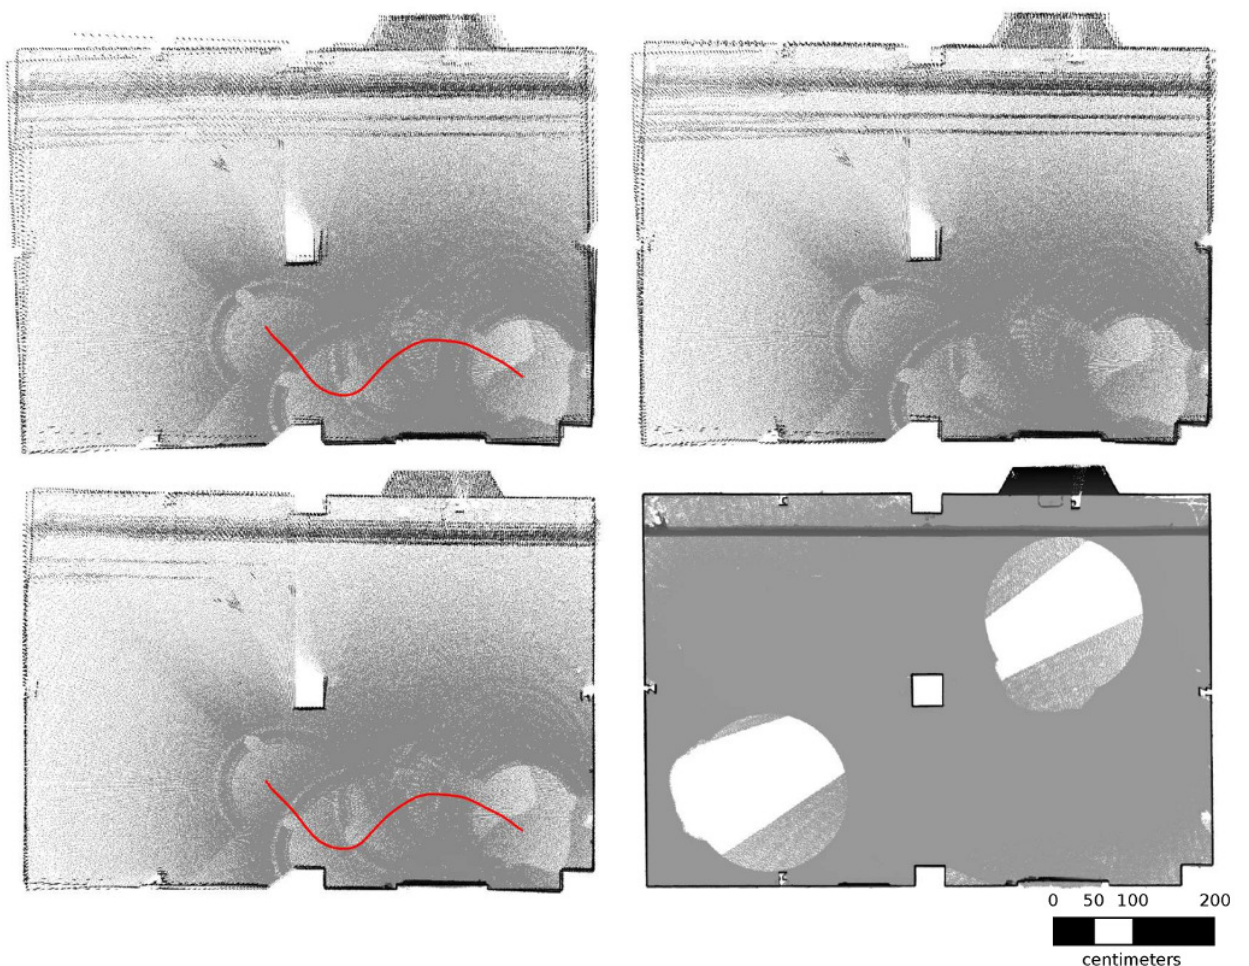
trajectory of the robot. ( Top ) The initial dataset with no registration ( Left ) and with